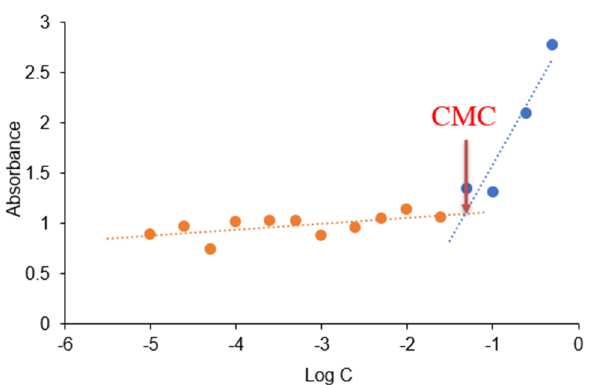
Figure 3. Plots of ultraviolet absorbance of I 2 versus concentration of the mixed micelles in water. CMC value was calculated by corresponding polymer concentration where a sharp increase in absorbance is observed. The orange and blue dots represent the polymer concentrations before and after the sharp increase in absorbance, respectively. The crosspoint between the orange and blue curves represents the CMC. (Mean ± SD, n = 3).